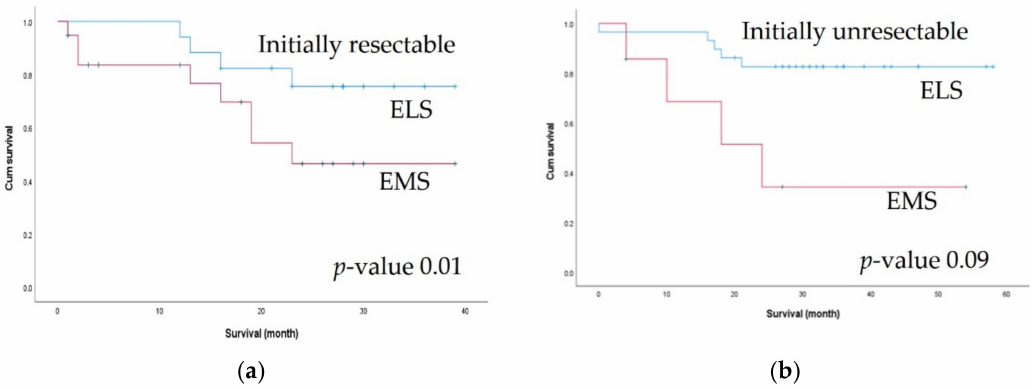
Figure 3. Comparison of 2-year survival outcomes between the elective surgery (ELS) and emergency surgery (EMS) groups according to initial resectability: ( a ) 2-year overall survival in initially resectable patients; ( b ) 2-year overall survival in initially unresectable patients. We performed an additional subgroup analysis for survival outcomes between patients who underwent elective surgery as the first treatment (n = 32) and those who underwent emergency surgery while receiving chemotherapy (n = 8). There was a trend towards better 2-year OS in the elective group (74.3% and 37.5%), but the difference was not statistically significant ( p = 0.052) (Figure 4). We also compared the effect of postoperative chemotherapy on patient survival. Of the 72 patients, 50 had received postoperative chemotherapy, with no significant difference in the rate of postoperative chemotherapy between the ELS and EMS groups (76.1% vs. 57.7%, p = 0.104). The patients were accordingly divided into four subgroups according to the treatment received: ELS with/without postoperative chemotherapy and EMS with/without postoperative chemotherapy. The subgroup of patients who underwent elective surgery followed by chemotherapy exhibited the best 2-year OS ( p < 0.001) (Figure